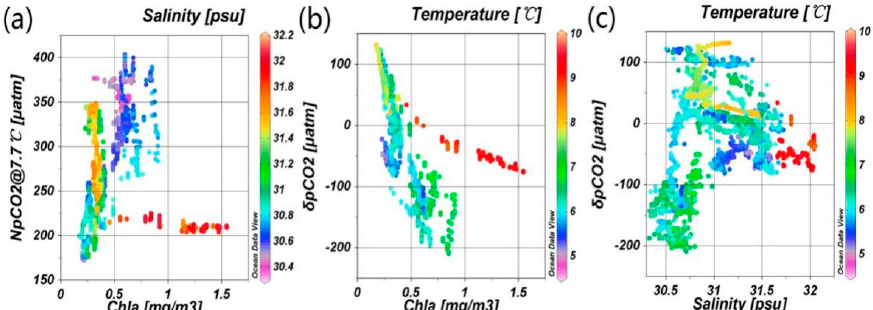
Figure 11. The relationship between p CO 2 , chla , temperature, and salinity in the shelf in July 2010 (locations were marked as M2 in Figure 7). ( a ) The relationship between p CO 2 normalized to reference temperature 7.7 °C (N p CO 2 ) and chla ; ( b , c ) are the relationships between δ p CO 2 (the difference between satellite-derived p CO 2 and in situ p CO 2 ) and chla or salinity, respectively. The high value in salinity and temperature (red color in all figures) were located in the east-most leg in the cruise track of M2 in Figure 7.